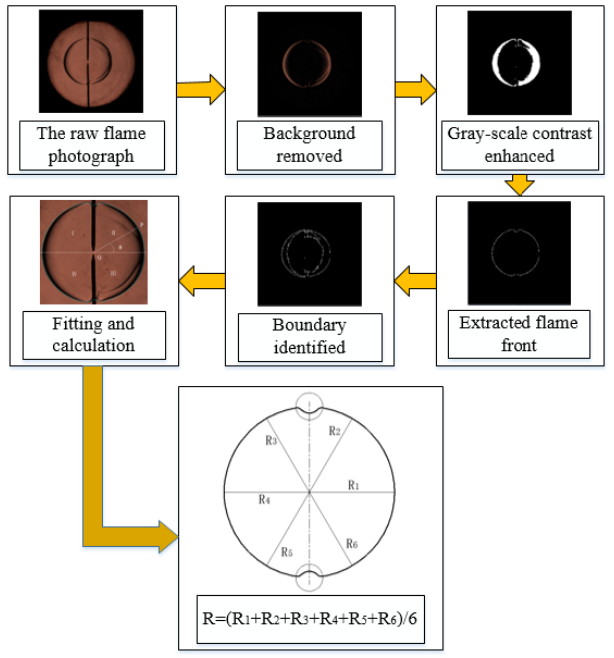
Figure 2. Diagram of extracting the flame radius.